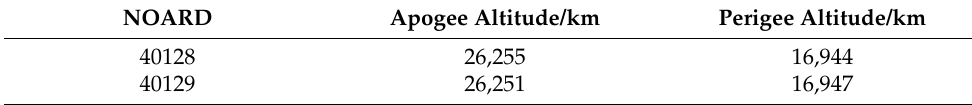
Table 1. Orbital parameters of two Galileo satellites launched in the early stage [22]. NOARD Apogee Altitude/km Perigee Altitude/km 40128 26,255 16,944 40129 26,251 16,947 The long-term evolutions of 24 other Galileo satellites are propagated. Figure 4 shows the orbital variations over 100 years.